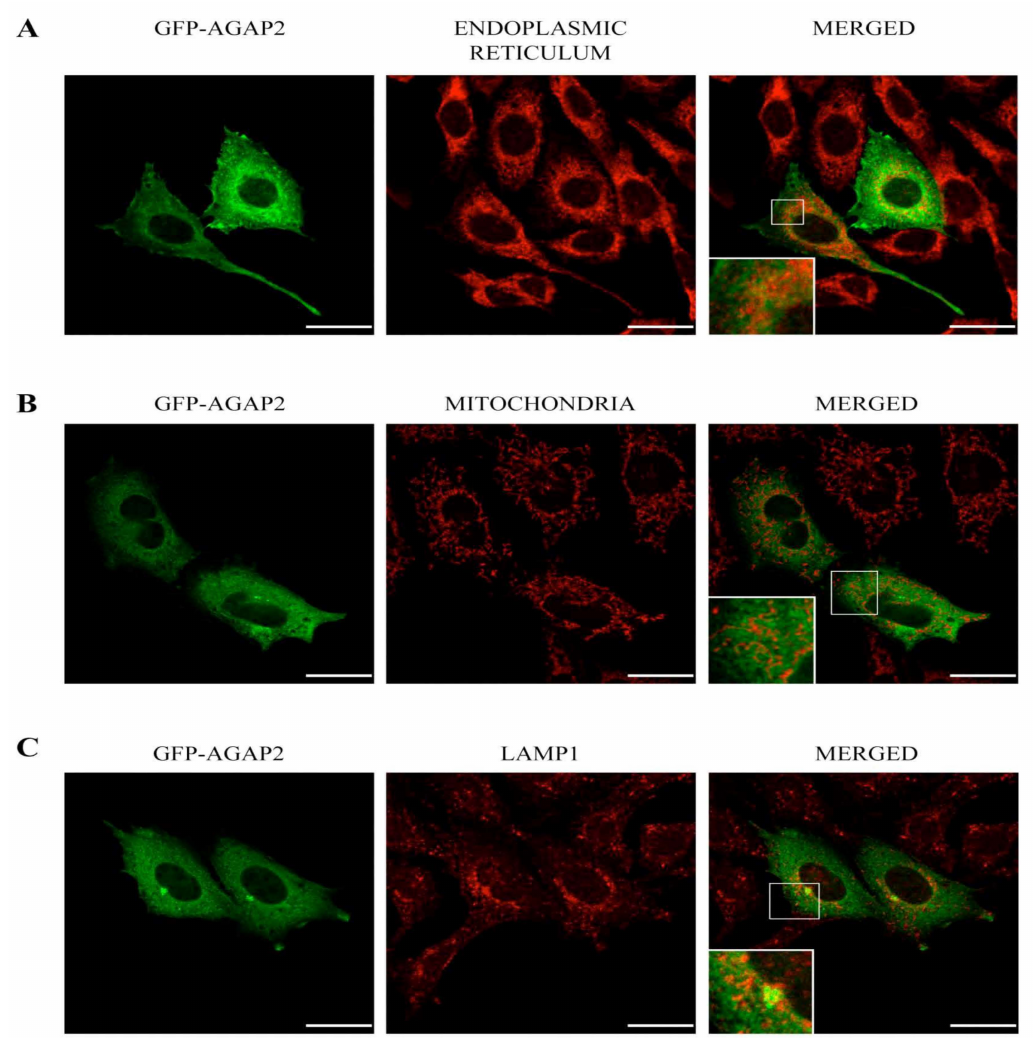
Figure 3. Co-localization of pEGFP-C1-AGAP2 with intracellular compartments. CHO-IIA cells tran- siently expressing pEGFP-C1-AGAP2 were labeled for endoplasmic reticulum with anti-calreticulin antibody ( A ), mitochondria with MitoTracker CMXRos ( B ) and late endosome/lysosome compart- ment with anti-LAMP1 antibody ( C ). A single confocal cross section of cells is represented. Insets show a magnification of the boxed areas. Bars, 20 µ